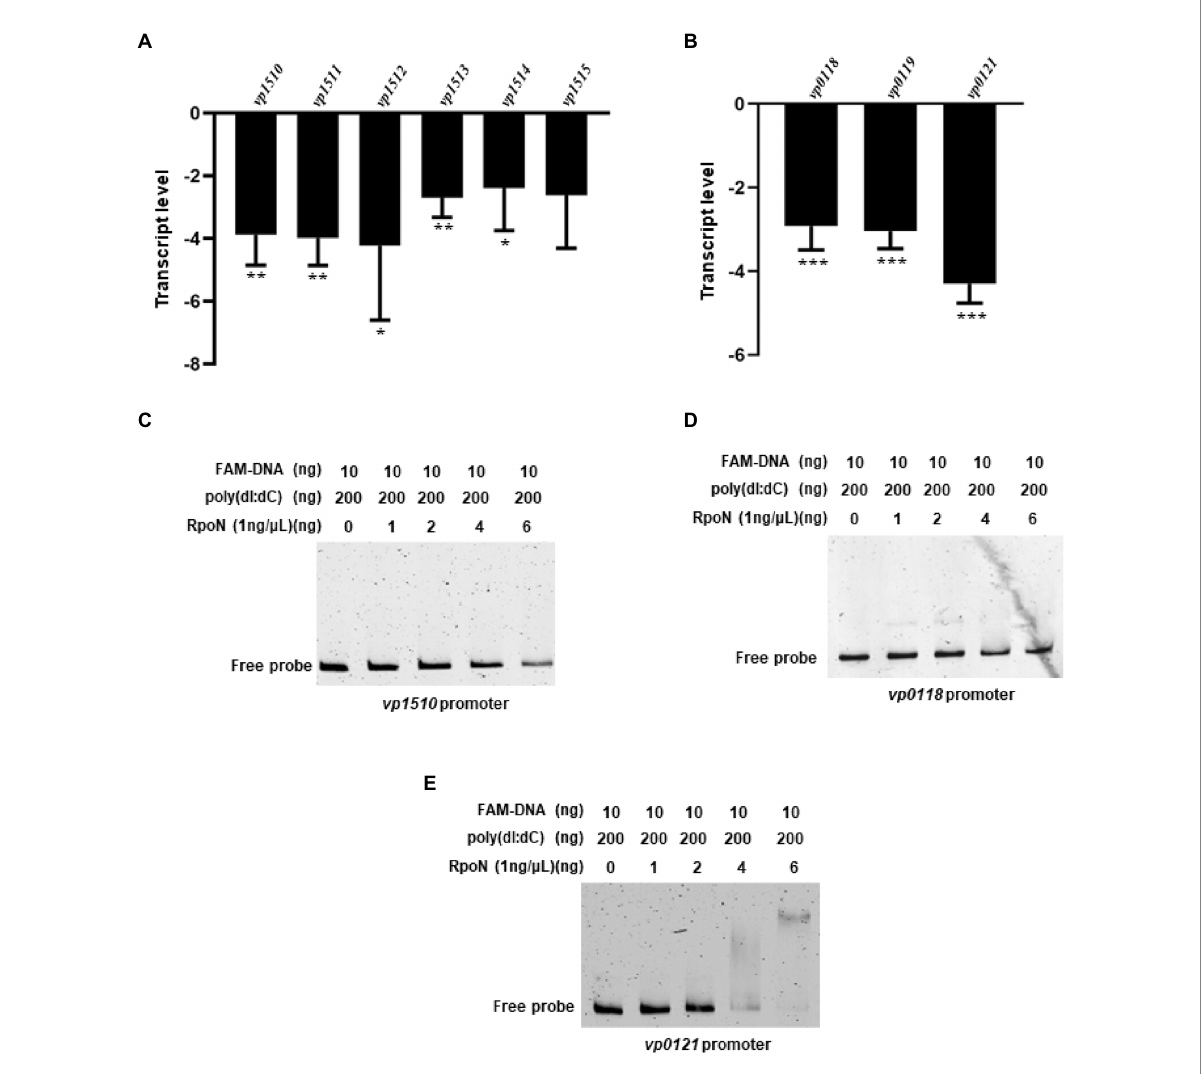
FIGURE 6 The RpoN regulates the expression of metabolism-associated genes. (A) qRT-PCR analysis of the expression levels of formate dehydrogenase genes ( VP1510 - VP1515 ) in Δ rpoN compared to WT. (B) qRT-PCR analysis of the expression levels of nitrogen regulatory protein ( VP0118-VP0119 ) and glutamine synthetase ( VP0121 ) associated genes in Δ rpoN compared to WT. The data are presented as the mean ± SD ( n = 3). * p < 0.05, ** p < 0.01, *** p < 0.001, Student’s t test analyzes Δ rpoN compared to WT. (C–E) EMSA analysis of the specific binding of RpoN protein to the promoters of VP1510 (C) and VP0118 (D) and VP0121 (E)